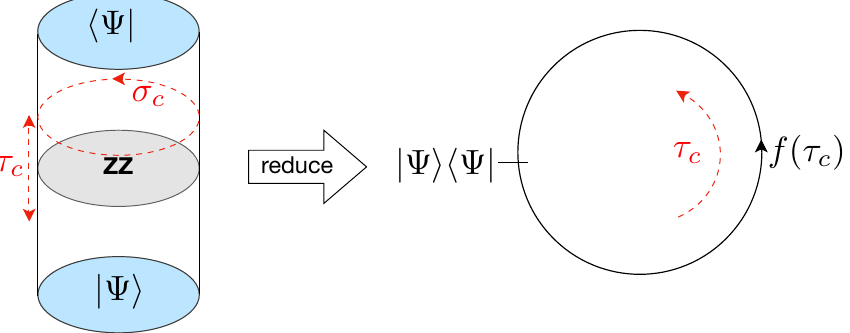
Figure 1. We obtain results on Schwarzian correlation functions by taking an appropriate limit of 2D Liouville theory with boundary conditions, or equivalently (as shown on the left) with the corresponding boundary states (details in section 2.3). The full cylinder is obtained when we imple- ment the ZZ boundary condition via a doubling trick, allowing us to extend the (cid:12)eld